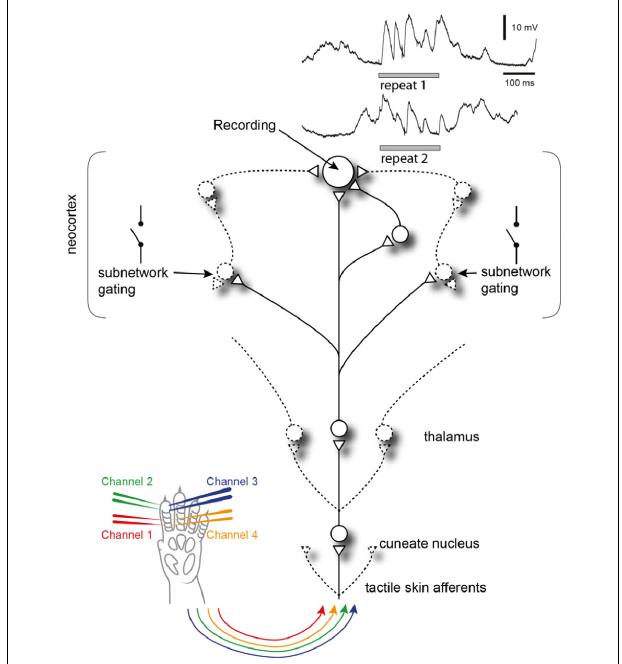
FIGURE 8 | Summary of findings. Recorded neocortical neurons receive a high number of synaptic inputs, each of which could potentially be controlled by a different subnetwork. Each subnetwork may be gated by other, relatively independent, events in the global neocortical circuitry. When the same tactile afferent stimulation pattern is provided at different points in time, these subnetworks may have different initial states, which will impact which subnetworks are gated in or out, which in turn will affect the appearance of the intracellular response (two traces shown in the top right corner). Circles are neurons, triangles are synapses, lines are axons and variable connections are drawn by dashed